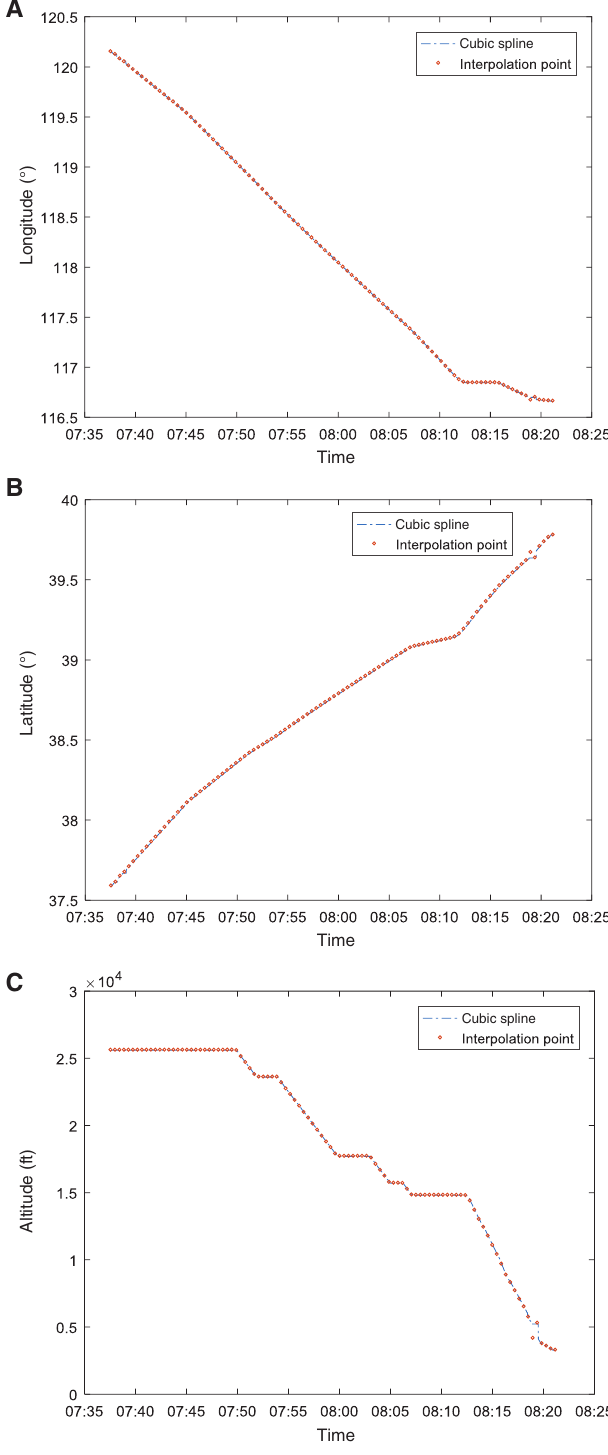
Figure 7: Example of Flight Trajectory Interpolation Results. (A) Longitude interpolation, (B) latitude interpolation and (C) altitude interpolation. As can be seen from Table 1, during the prediction process, the prediction time error of the model is con- trolled within 1 min, and the prediction altitude can also reflect the trend of the actual trajectory, with the maximum error not exceeding 50 m, so the prediction accuracy is relatively